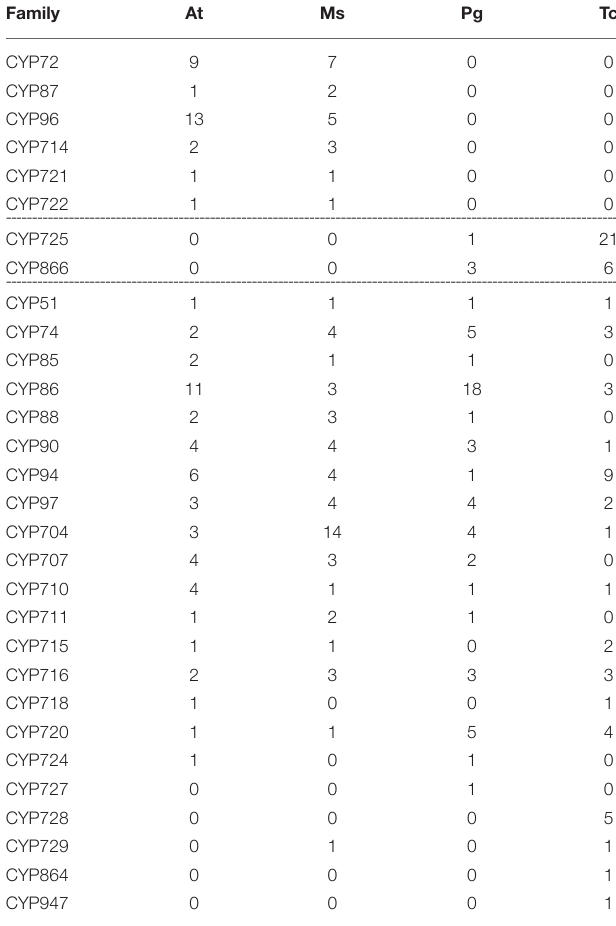
TABLE 4 | Comparison of non-A-type CYP450 families among A. thaliana (At), M. sativas (Ms), P. glauca (Pg), and T. chinensis (Tc). Family